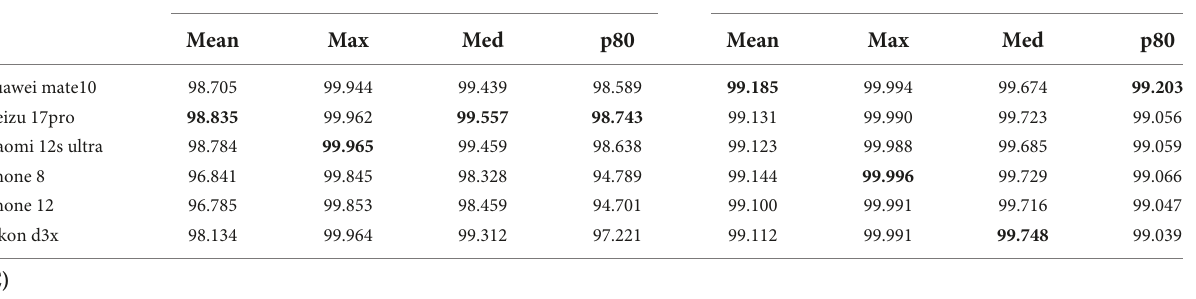
TABLE 3 Performance comparison of raw responses in OLS method and ALWLR method for six devices: (A) RMSE, (B) GFC, (C) (cid:49) E ∗ ab , and (D) (cid:49) E 00 . (A)